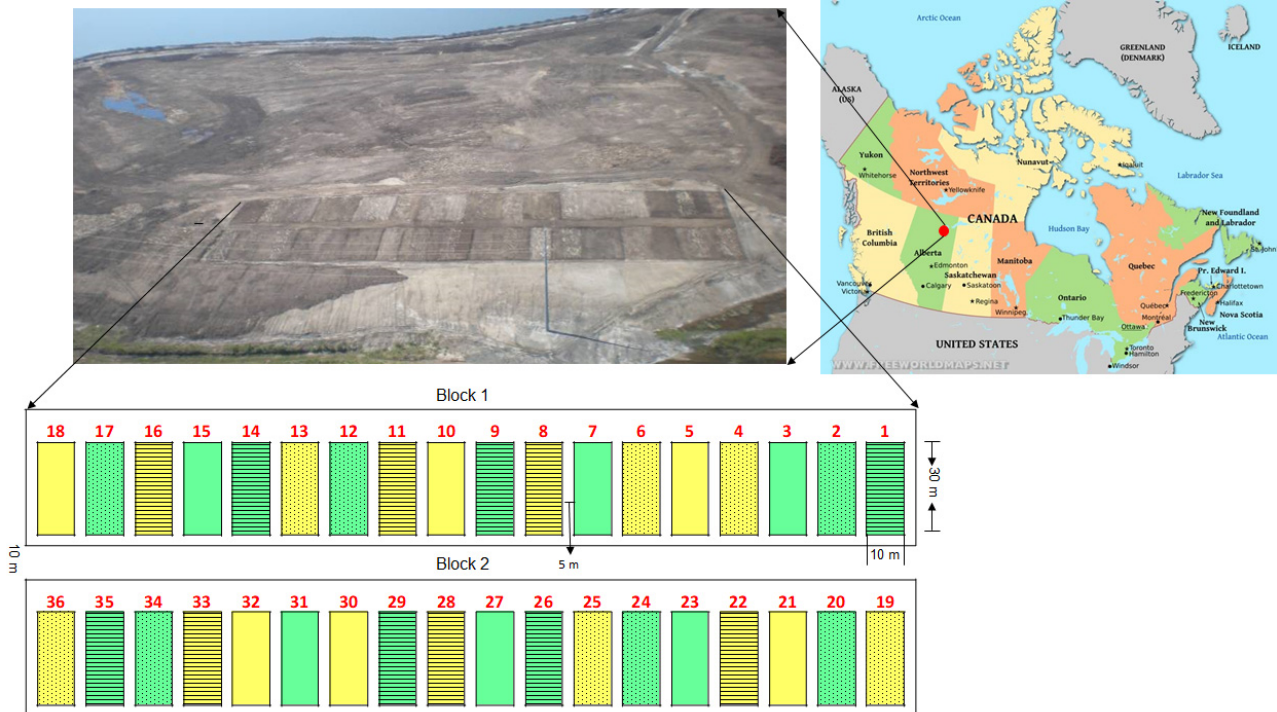
Figure 1. Location of research sites. Yellow plots have LFH mineral soil mix cover and green plots have peat mineral soil mix cover. Plots without lines or dots were control or no CWD, plots with dots were Populus tremuloides woody debris, and plots with horizontal lines were Picea mariana woody debris.